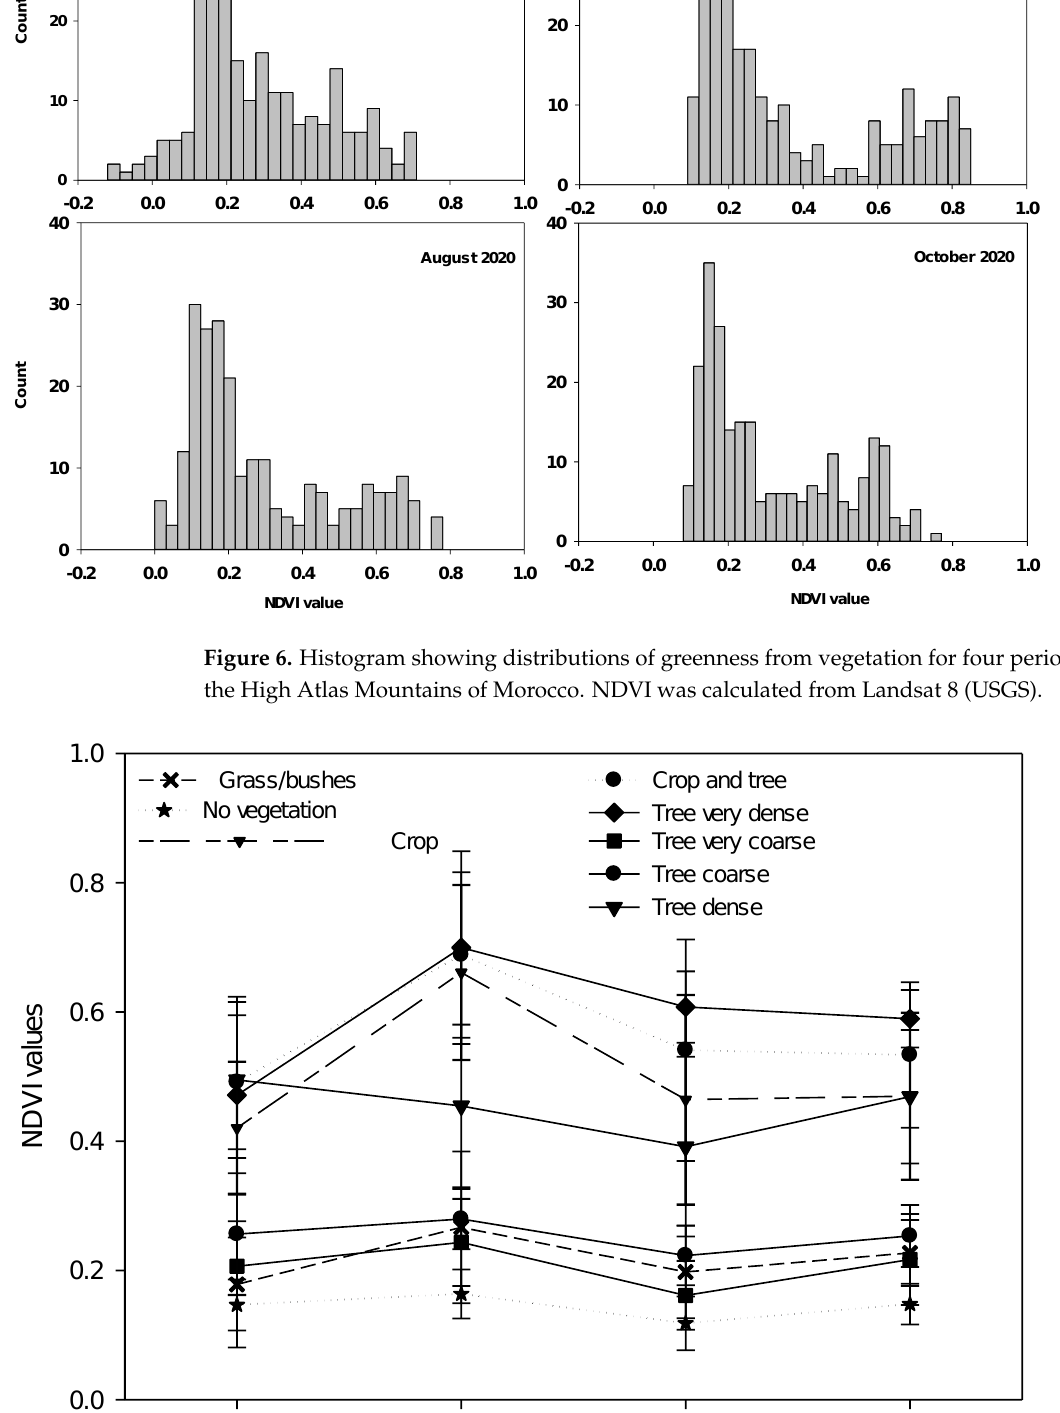
Figure 8. Rules-based decision tree to classify land-use and land cover in the High Atlas Mountains of Morocco. Table 6. Statistics of NDVI values for eight vegetation types (no vegetation, crop, crop and tree, grass/bushes, tree coarse, tree dense, tree very coarse, and tree very dense) in the High Atlas Moun- tains of Morocco. To separate means a pairwise multiple comparison procedure (Holm – Sidak Method) was used.